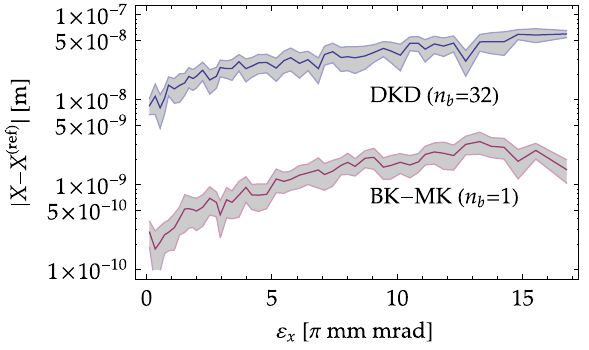
FIG. 5. One-turn errors in X versus amplitude for several 32 (upper curve), different integrators: drift-kick with n b ¼ 1 (lower curve). and BK/MK with n b ¼